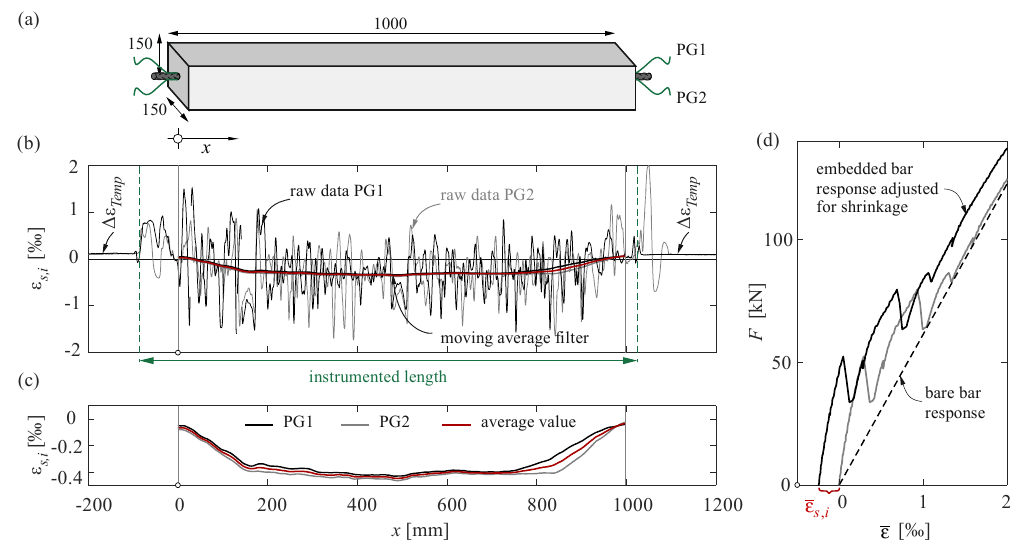
Figure 8. Initial strain state in an embedded reinforcing bar (Specimen ERH): ( a ) geometry and instrumentation (PG: polyimide FOS in a groove)—dimensions in [mm]; ( b ) shrinkage strain measured by DFOS at an age of 150 d (raw data); ( c ) shrinkage strain after post-processing and ( d ) global response of an embedded reinforcing bar subjected to deformation controlled uniaxial tensile loading with and without adjustment for shrinkage.